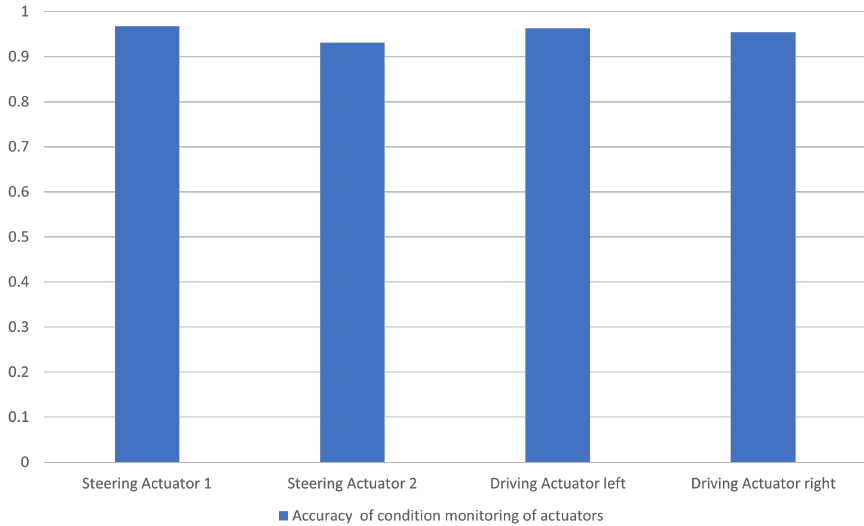
Figure 25. Accuracy of condition monitoring of different